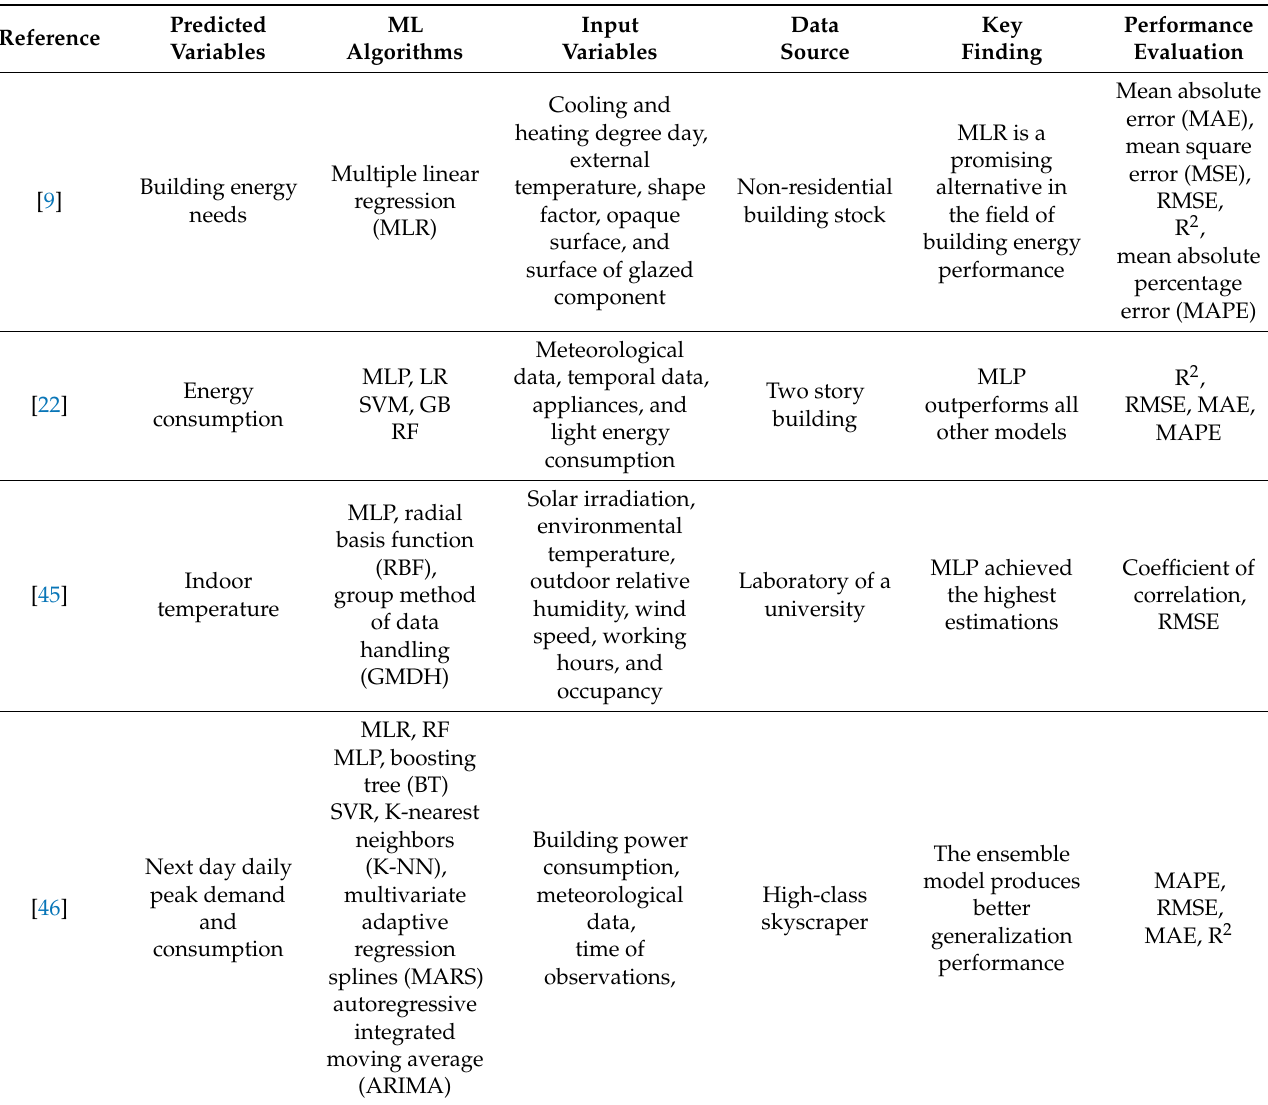
Figure 5. Recorded parameters of the heating experiment. Table 1. Machine learning-based thermal